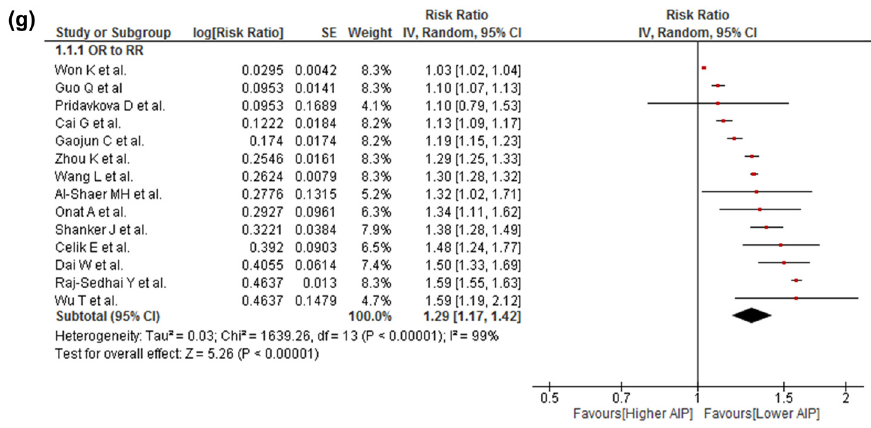
Figure 2: ( a ) Association of AIP and risk for CAD. ( b ) Subgroup analysis according to the origin country of the association between AIP and risk for CAD. ( c ) Subgroup analysis according to the study design of the association between AIP and risk for CAD. ( d ) Subgroup analysis according to CAD de fi nition of the association between AIP and risk for CAD. ( e ) Subgroup analysis according to the gender of the association between AIP and risk for CAD. ( f ) Sensitivity analysis according to the risk of bias of the association between AIP and risk for CAD. ( g ) Sensitivity analysis according to the transformation from OR to